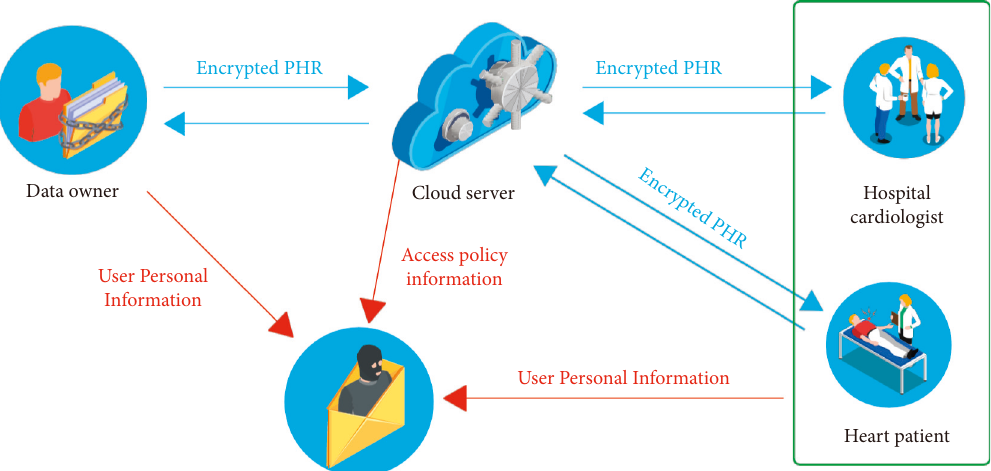
Figure 1: Traditional CP-ABE information disclosure model.